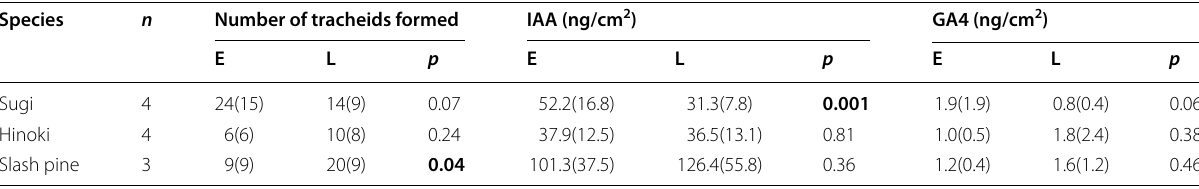
Table 2 Characteristics of annual ring formation and plant hormones among three conifer